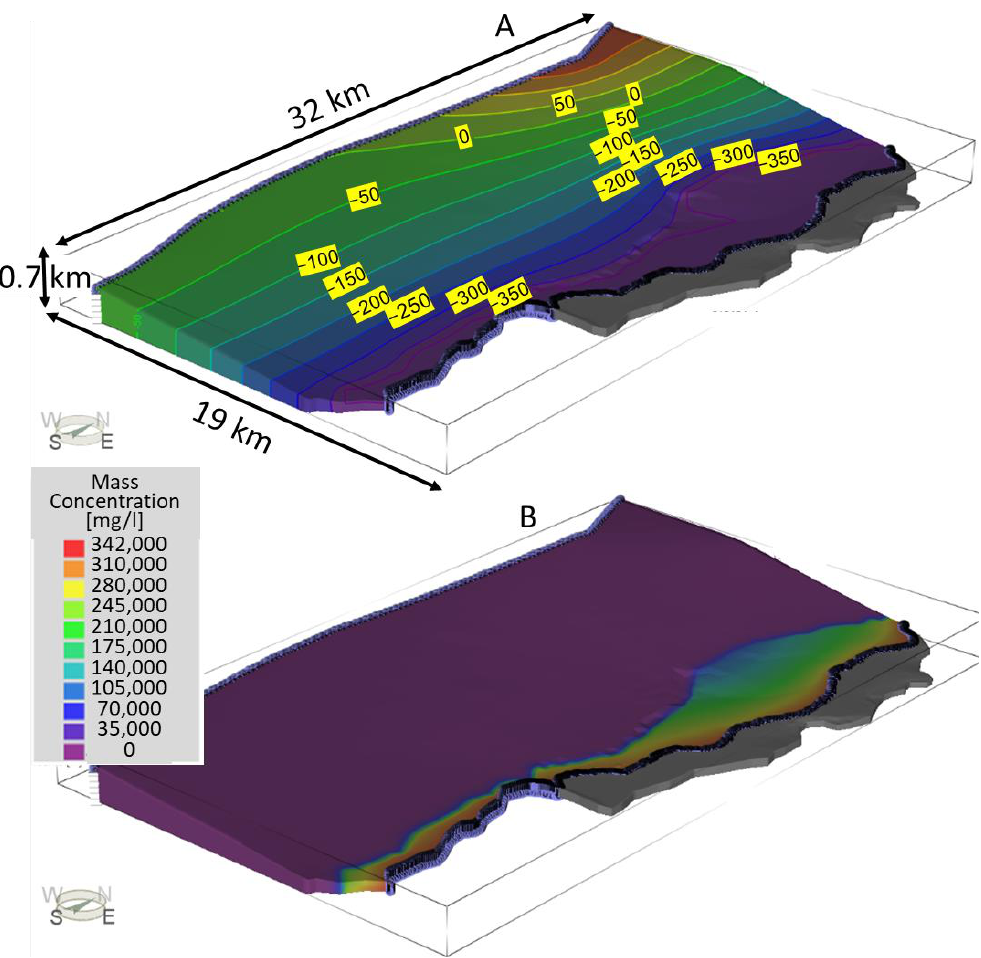
Figure 9. Initial conditions for the flow ( A ) and transport ( B ) hydrogeological modeling, given a stable Dead Sea level at − 395 mbsl, as measured before 1980. The gray area in both figures was not included in the modeling at this stage because it was below the lake-water level.